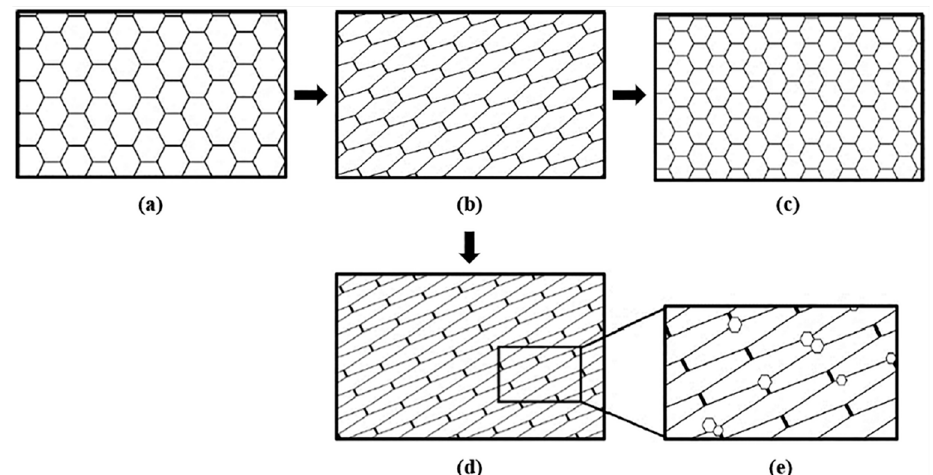
Figure 1. Schematic representation of the expected morphological evolution of austenite grains during hot torsion testing (shear deformation). The arrows indicate the progression of morphological changes. Austenite grains are ( a ) initially equiaxed and ( b ) elongate from imposed shear strain. Next, austenite grains either ( c ) recrystallize or ( d ) continue to deform in shear until ( e ) sufficient driving force is present for partial recrystallization. The torsional axis is vertical to the page. Adapted with permission from [19].